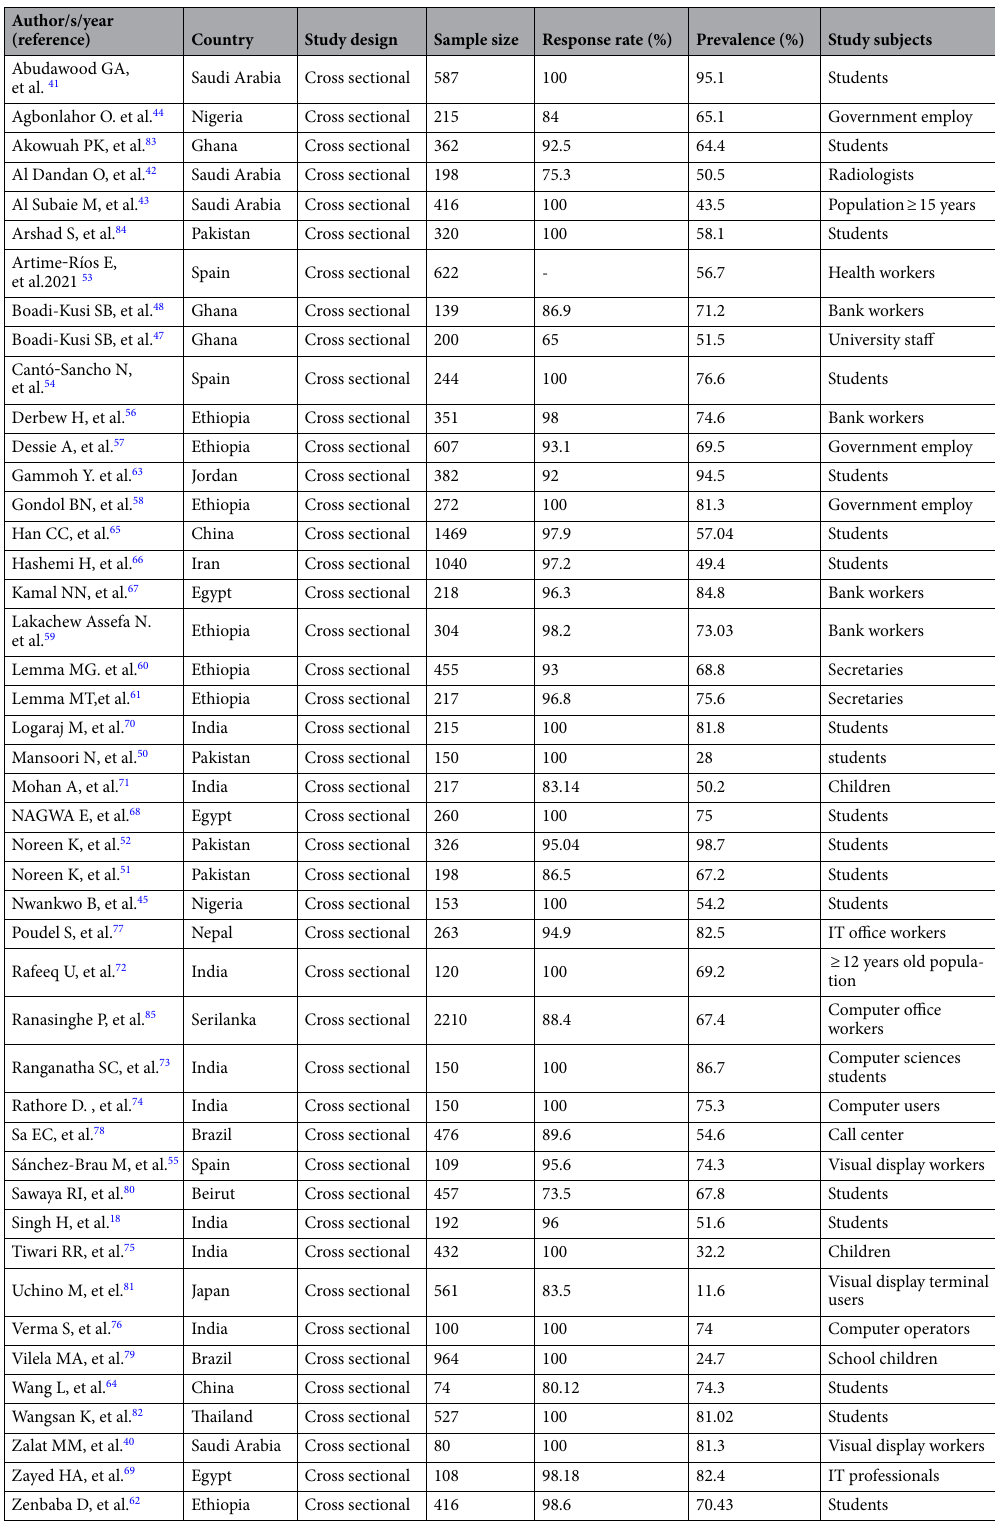
Table 1. Characteristics of included studies in the meta-analysis of computer vision syndrome,